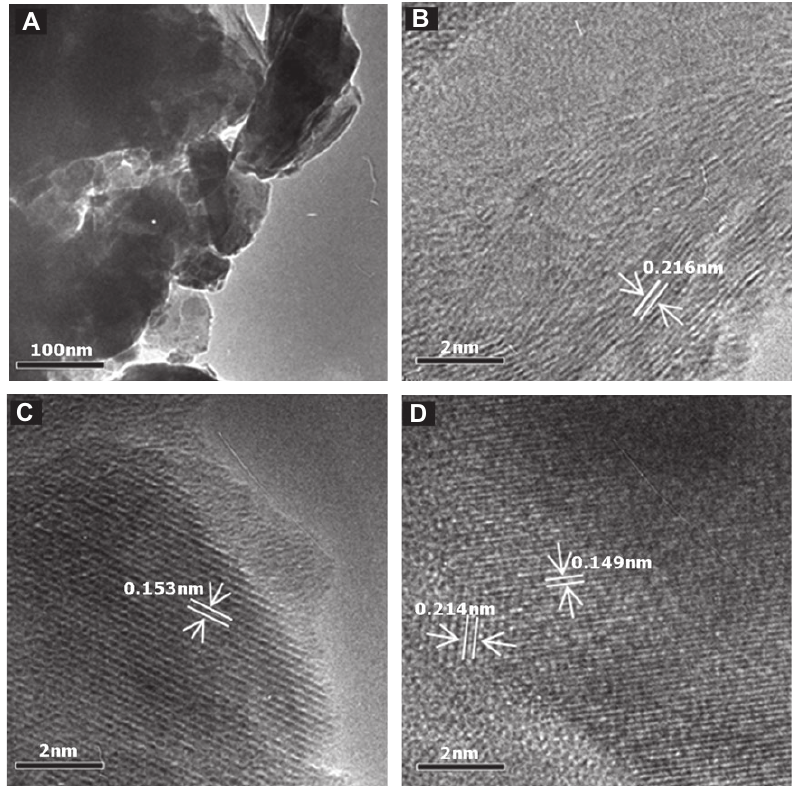
Figure 5 HRTEM morphologies of the alloying coating in sample 1. (A) Test location, (B) TiB, (C) TiC, (D) TiN and Ti(CN).